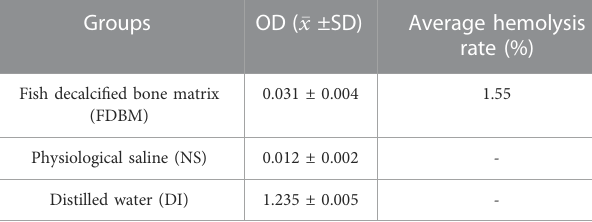
TABLE 2 OD and hemolysis rate in each group (n = 10, per group).